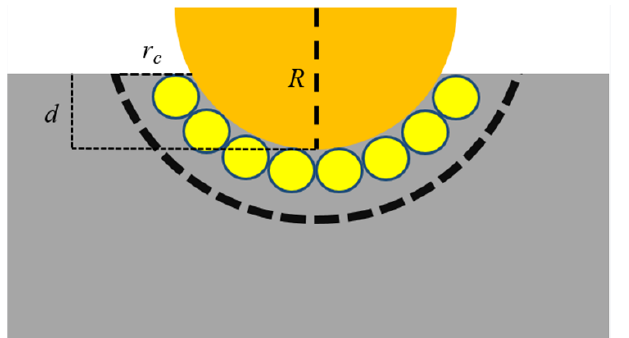
Figure 2. Schematic diagram of the hardness calculation method of the model when the indenter is pressed into the matrix at a depth of d .